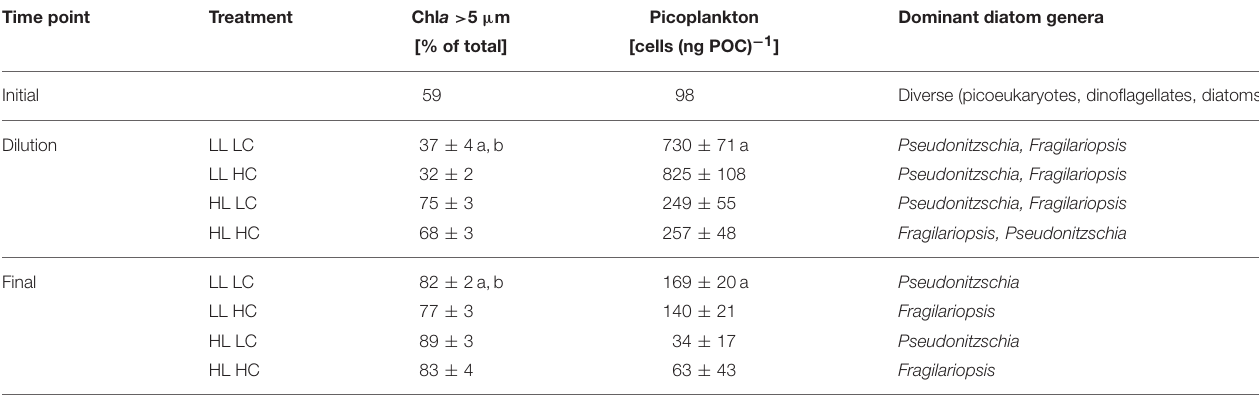
TABLE 2 | Composition of phytoplankton assemblages characterized by the proportion of the > 5 µ m size-fraction to total Chl a , C-normalized picoplankton counts as well as the dominant diatom genera before the dilution and at the end of the experiment ( n = 3; mean ± 1